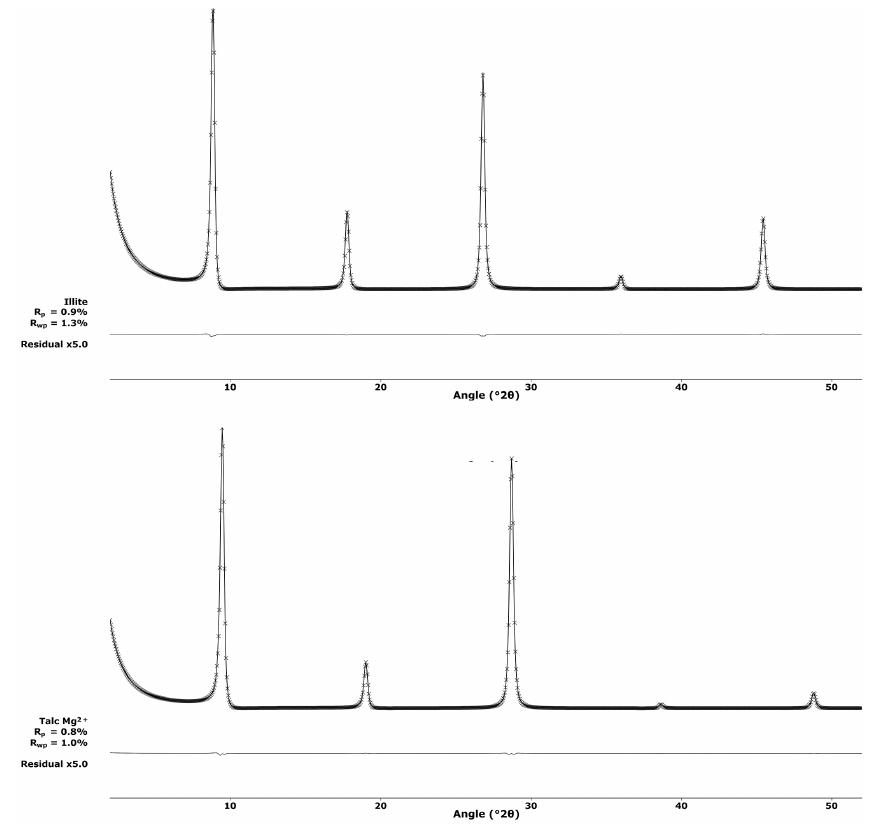
Figure 3. Calculated patterns for discrete illite (top) and talc (bottom), showing nearly identical output for PyXRD (solid line) and Sybilla (crosses). For clarity the residual patterns are scaled to 5 times their original